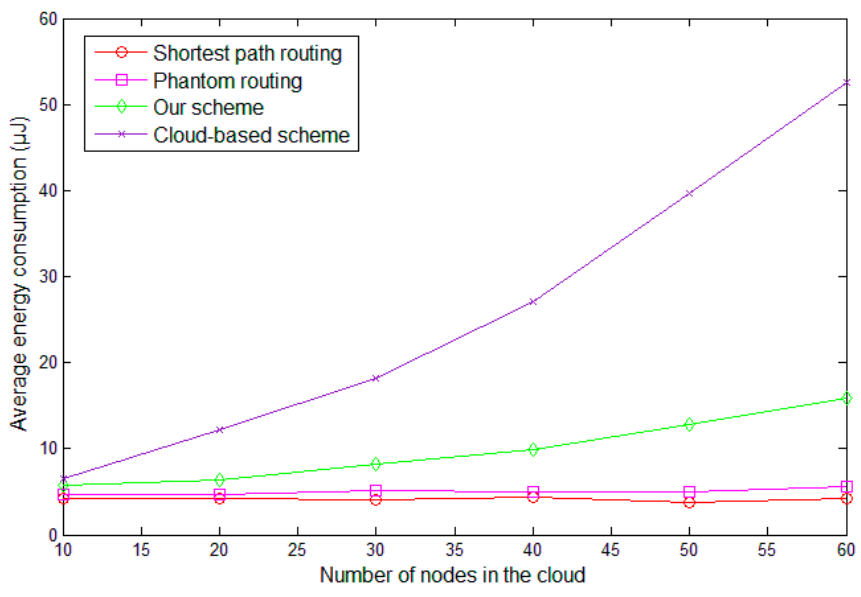
Figure 9. Energy consumption with different sizes of the cloud.